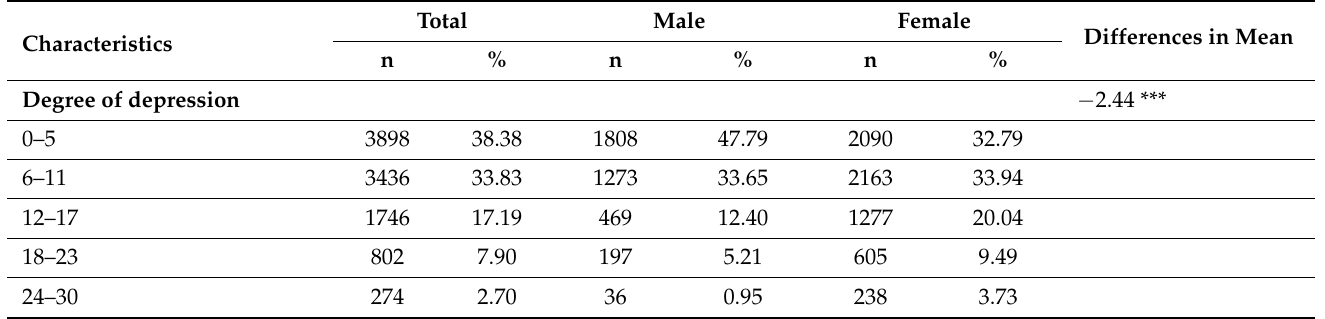
Table 1. Sample characteristic